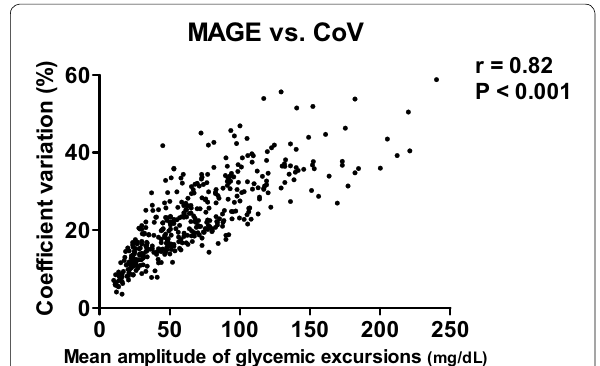
Fig. 5 Correlations among the two indicators for glycemic variability. MAGE mean amplitude of glycemic excursions, CoV coefficient of